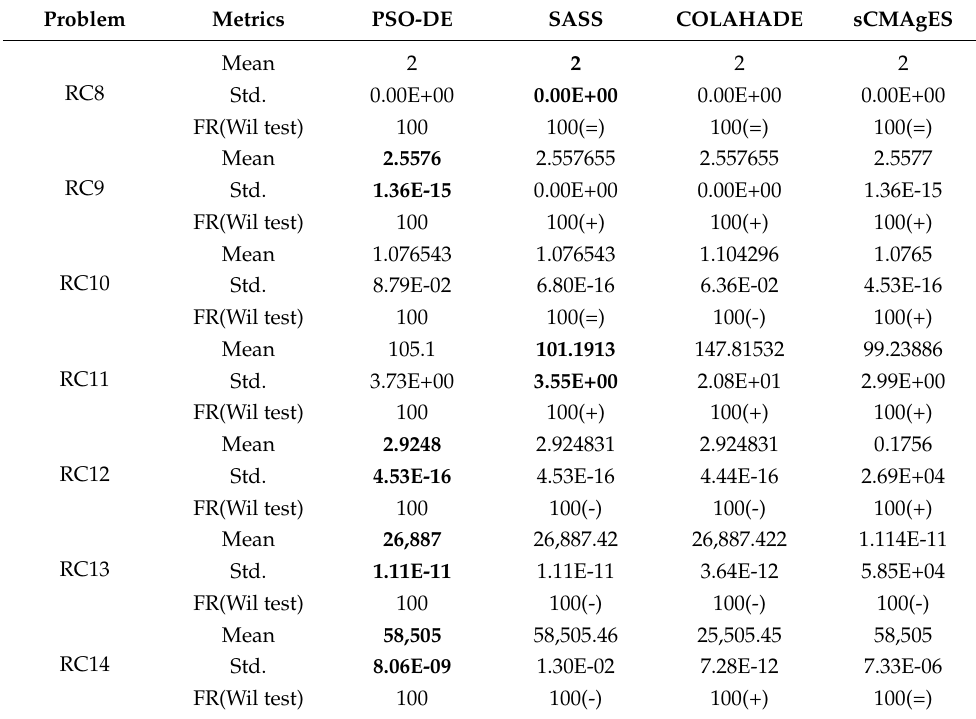
Table 9. Experimental results for process synthesis and design problems (RC08-RC14).